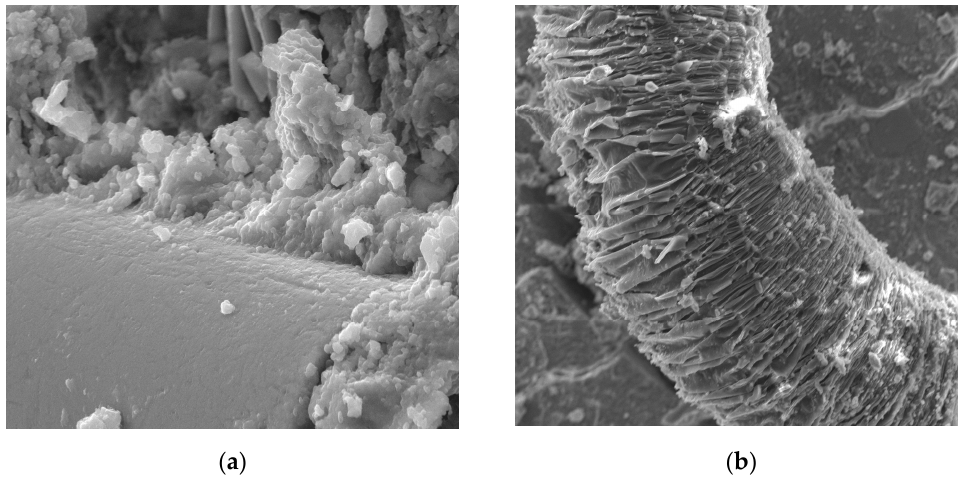
Figure 17. Contact zone of cement paste with POF after four-point static bending test: ( a ) 20,000× magnification; ( b ) 10,000× magnification.